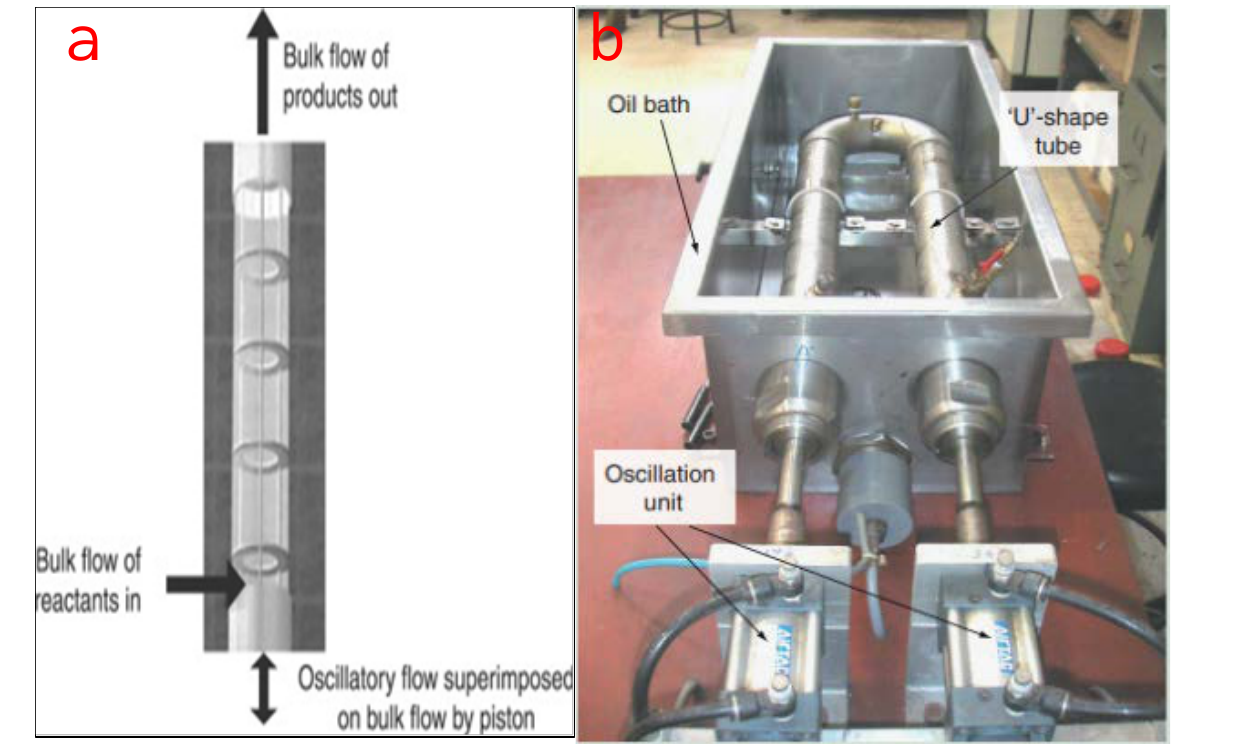
Figure 12. ( a ) Schematic representation of an oscillatory flow reactor; ( b ) a typical oscillatory flow reactor for biodiesel production. Adapted from